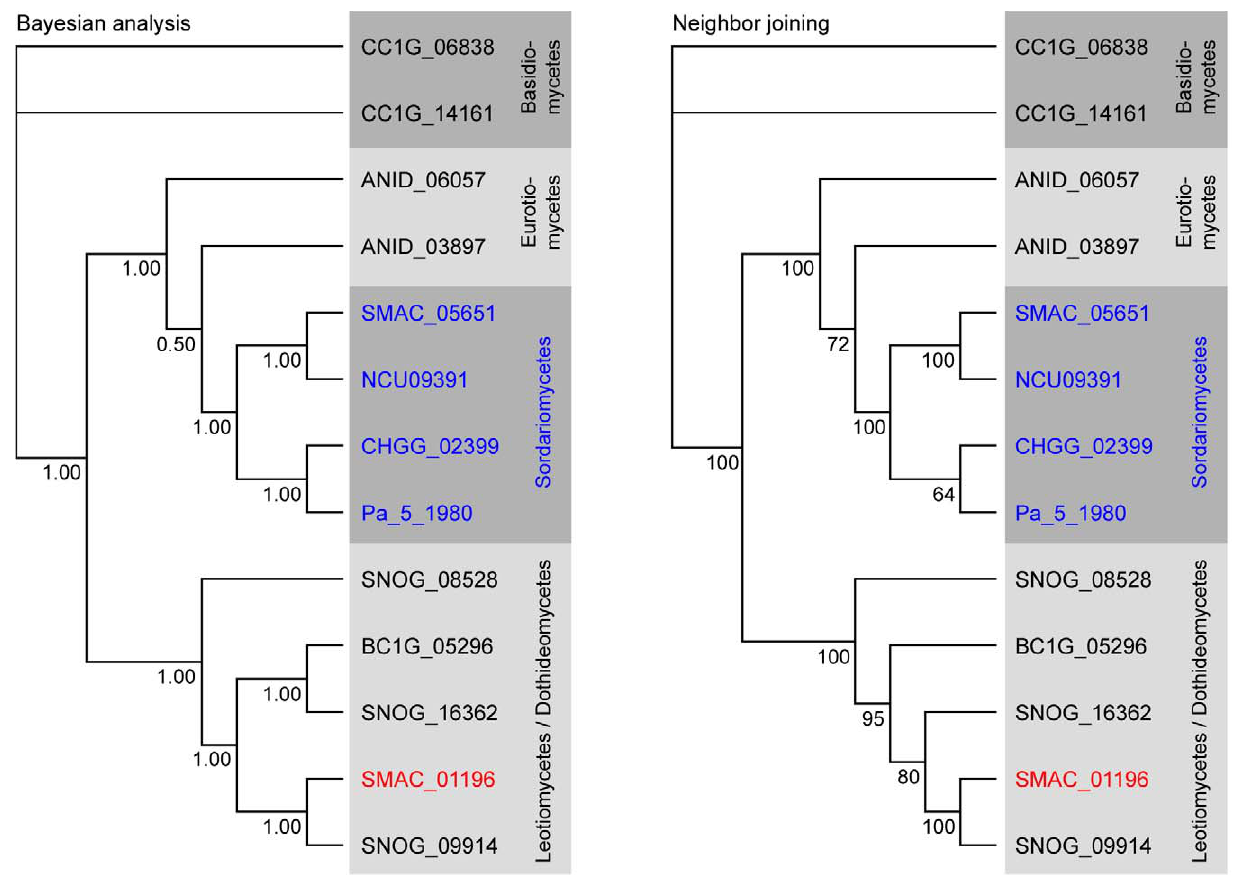
Figure 9. Phylogenetic analysis of the predicted phenylalanine ammonia lyase (PAL) proteins from eight fungi. Numbers at branches indicate bootstrap support (10,000 bootstrap replications) in % for the neighbor joining tree, and clade credibilities for the Bayesian tree. Classes given on the right correspond to the taxonomy used by Liu and Hall [171], and in the NCBI Entrez Taxonomy Database (http://www.ncbi.nlm.nih.gov/ entrez/query.fcgi?db=Taxonomy). Sordariomycete proteins are given in blue with the exception of the S. macrospora protein SMAC_01196 that clusters with the Leotiomycete/Dothideomycete group and is given in red. Sequences for P. anserina were obtained from the Podospora anserina genome project (http://podospora.igmors.u-psud.fr/index.html) and for all other fungi from the Fungal Genome Initiative of the Broad Institute at (http://www.broad.mit.edu/ annotation/fungi/fgi/index.html). AN: Aspergillus nidulans , BC: Botrytis cinerea , CC: Coprinus cinereus (outgroup), CH: Chaetomium globosum , NC: Neurospora crassa , SM: Sordaria macrospora , PA: Podospora anserina , SN: Stagonospora nodorum ( Phaeosphaeria nodorum ).